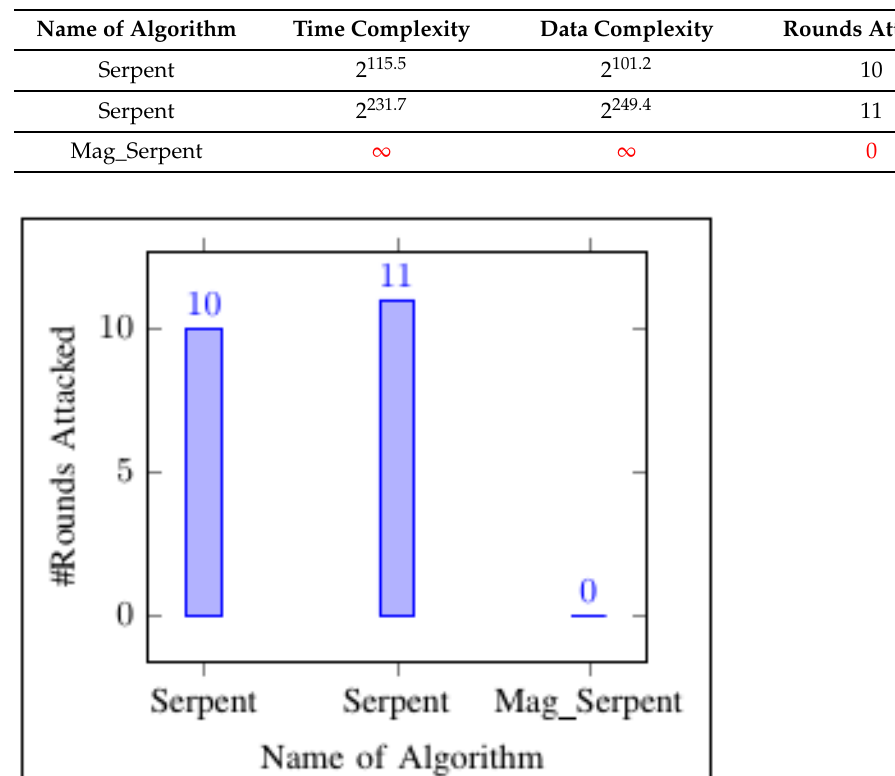
Table 18. Results of DL Attack.